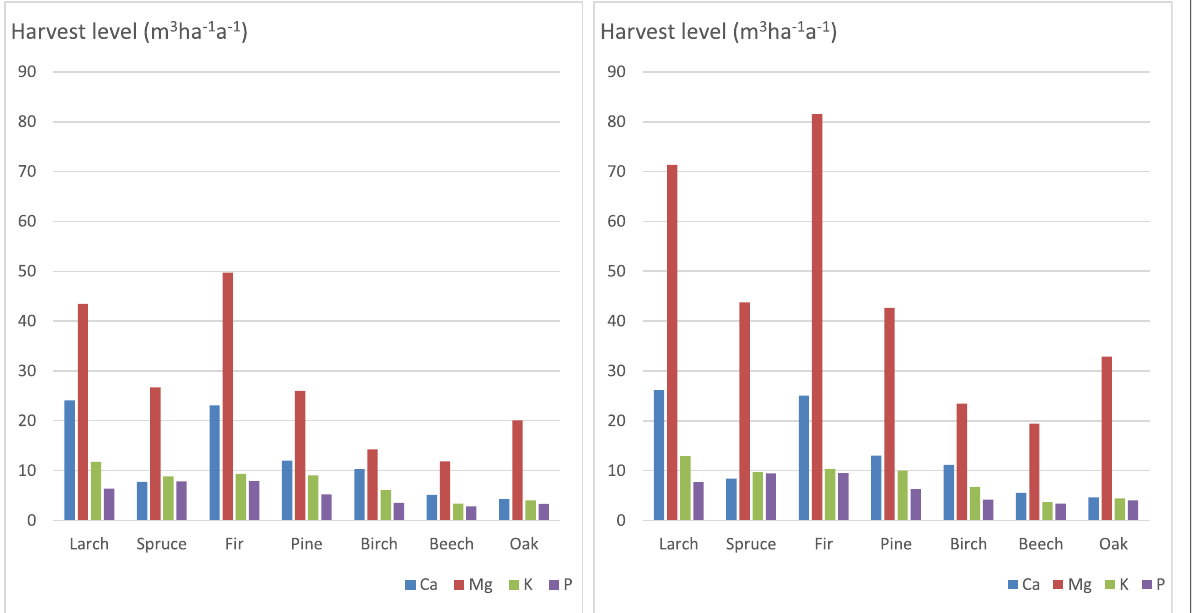
Fig. 2 Limits for sustainable harvest for the seven tree species, avoiding nutrient depletion depending on the element considered, for poor sandy soils (left) and moderate poor sandy soils (right) in the central sandy soil region in the